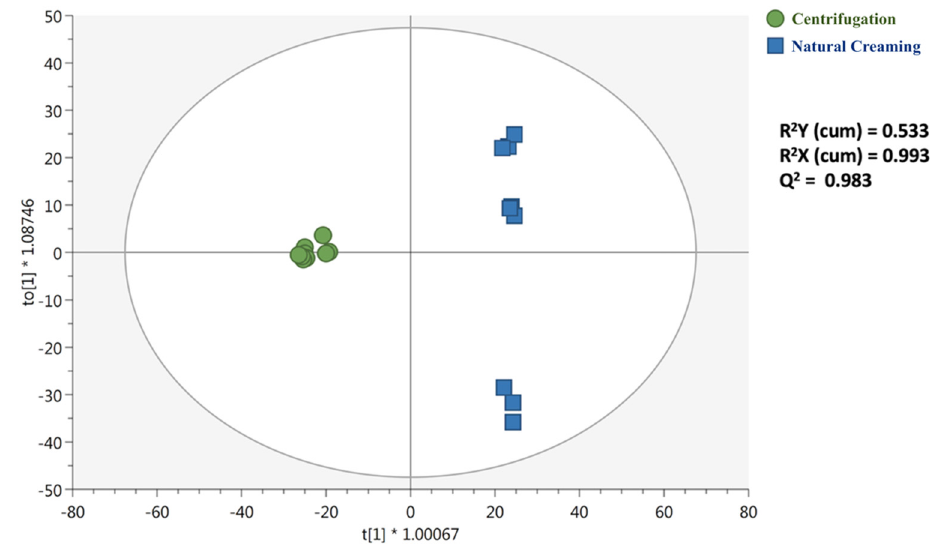
Figure 3. Orthogonal projections to latent structures discriminant analysis (OPLS-DA) score plot considering the different separation technique (i.e., centrifugation vs. natural creaming). The individual sample replications (n = 3) are provided in the OPLS-DA score plot.